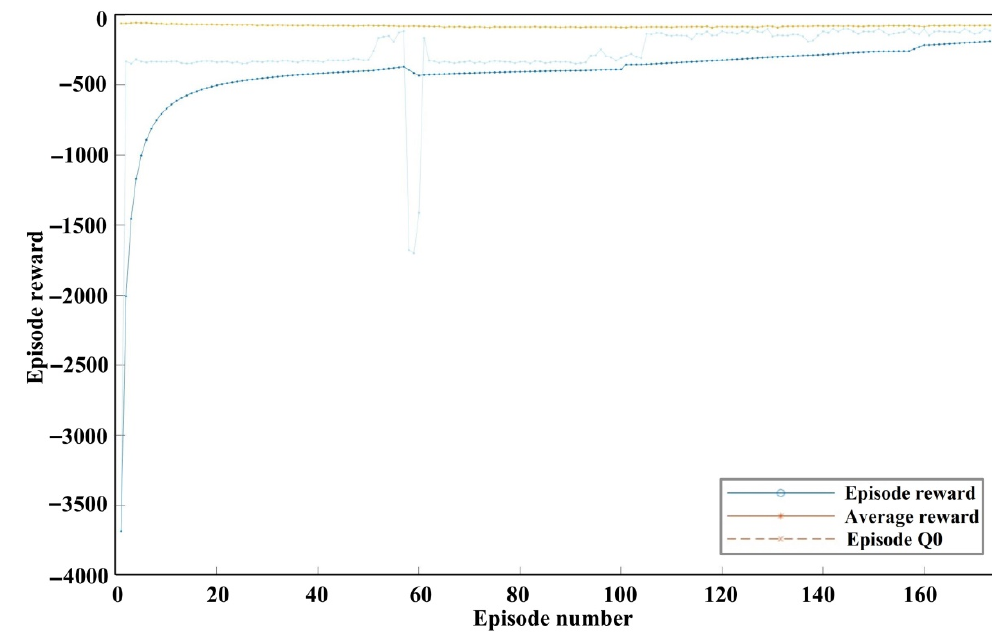
Figure 12. The MATLAB Simulink subsystem of the RL-TD3 agent for the correction of the u dref and u qref commands. The Reward at every step in this case was calculated using the following equation: (